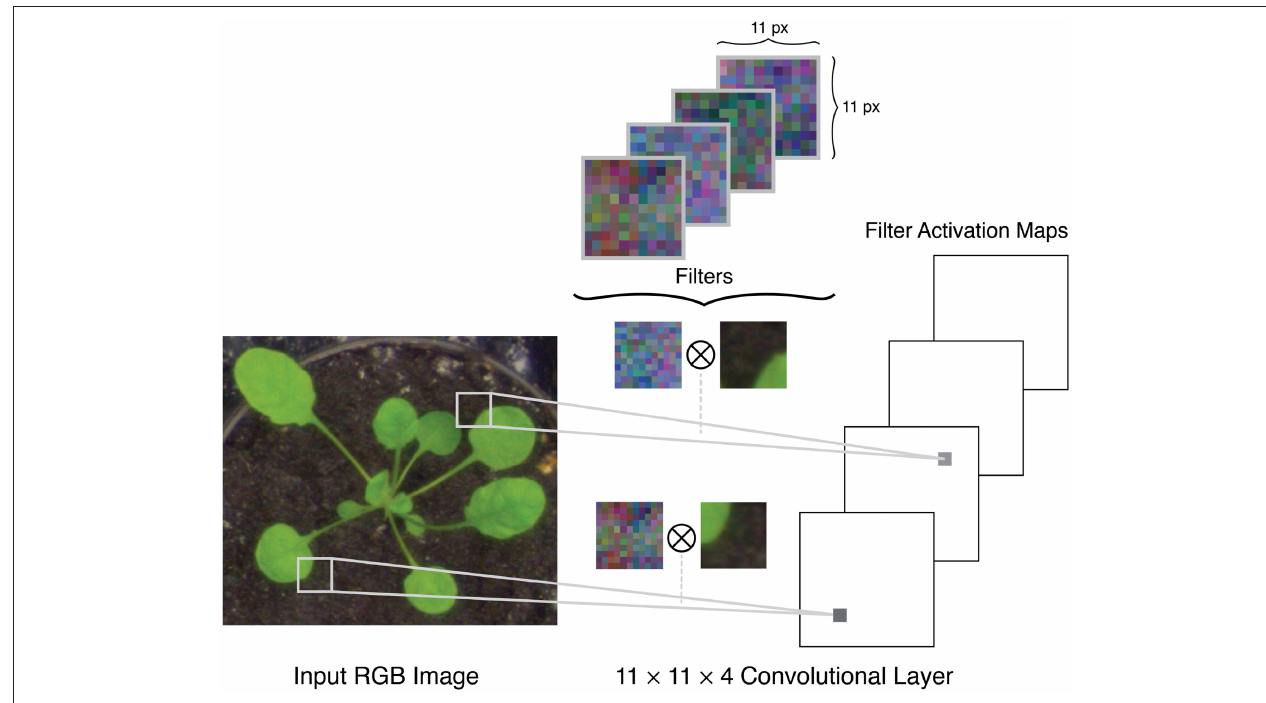
FIGURE 2 | Example of filters in the first convolutional layer of a network being applied to the input image in stride